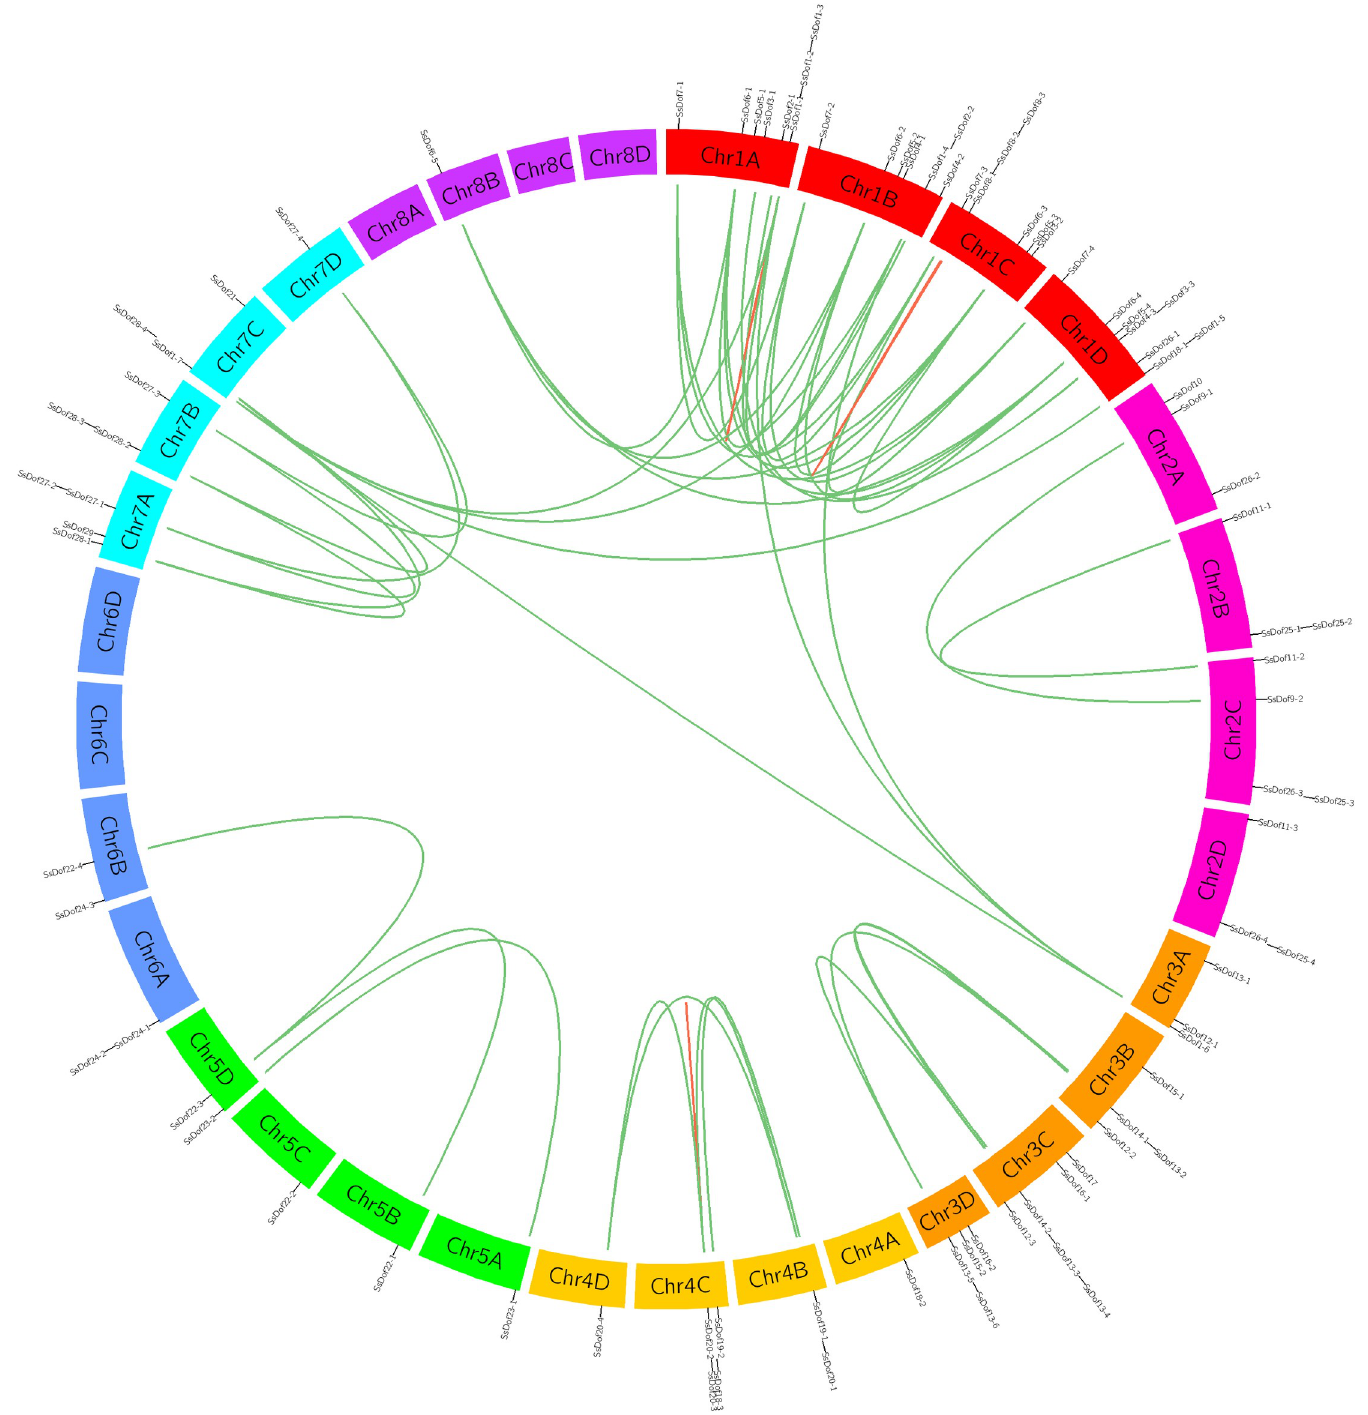
Fig 4. Chromosomal locations of the SsDof genes in S . spontaneum . Green lines indicate segmental duplication gene pairs, while the red lines show tandem duplication gene pairs. The chromosome numbers are shown in the center of sugarcane chromosomes.